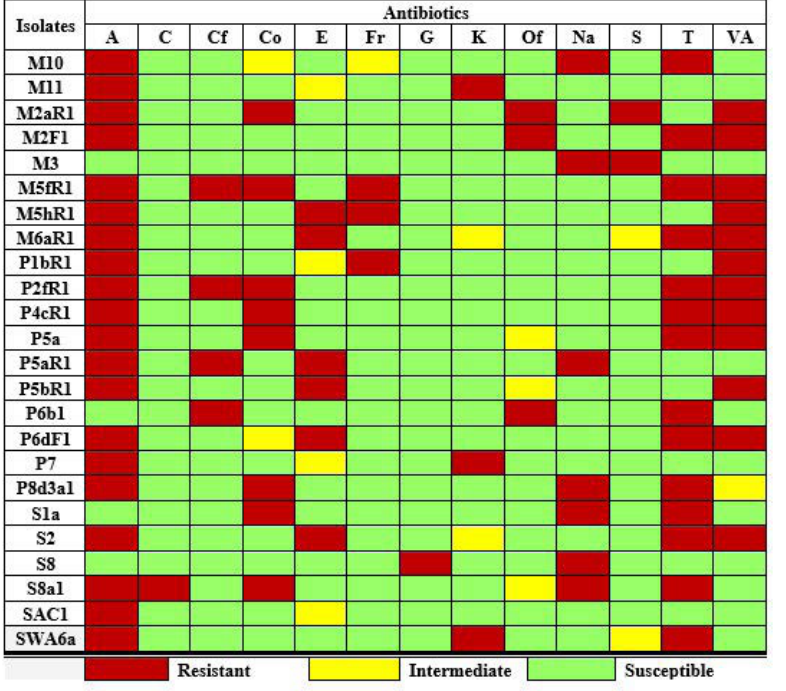
Table 2. Antibiogram results of twenty-four isolates from the soil sample against thirteen different Antibiotics. The table is colour coded according to the legend given